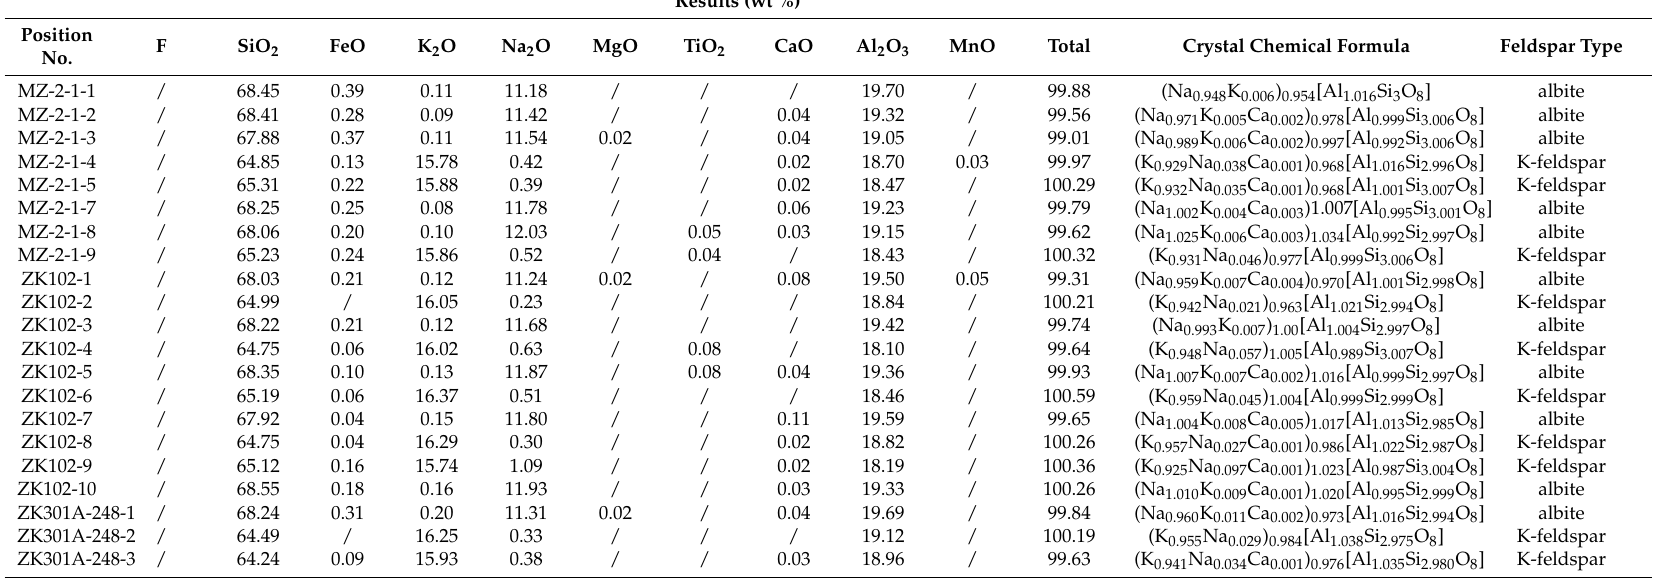
Table 1. Results of electron probe analysis on feldspar inclusions within porphyritic quartz (quoted from Xu et al.